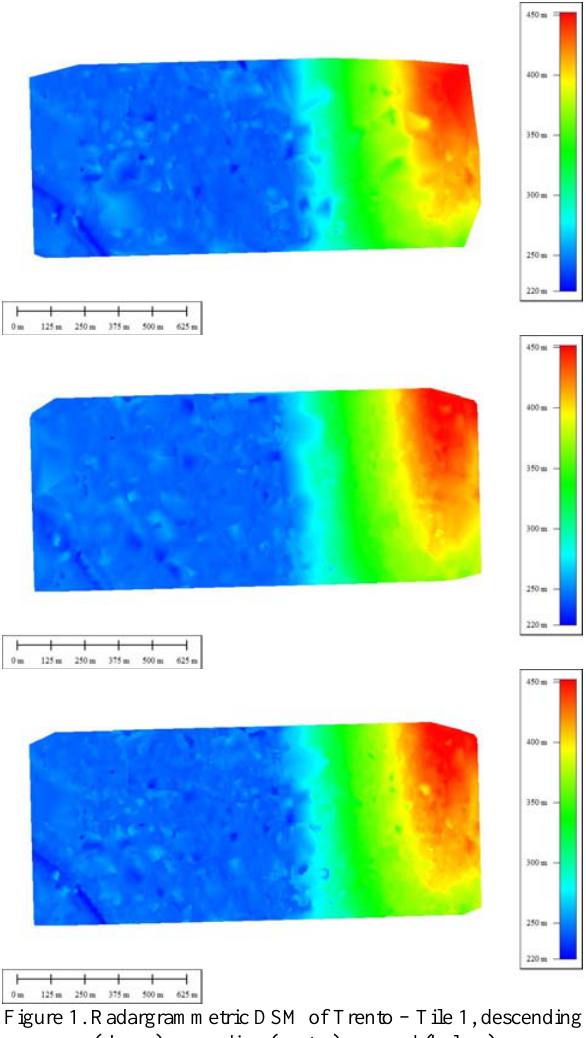
Figure 1. Radargrammetric DSM of Trento – Tile 1, descending (above), ascending (centre), merged